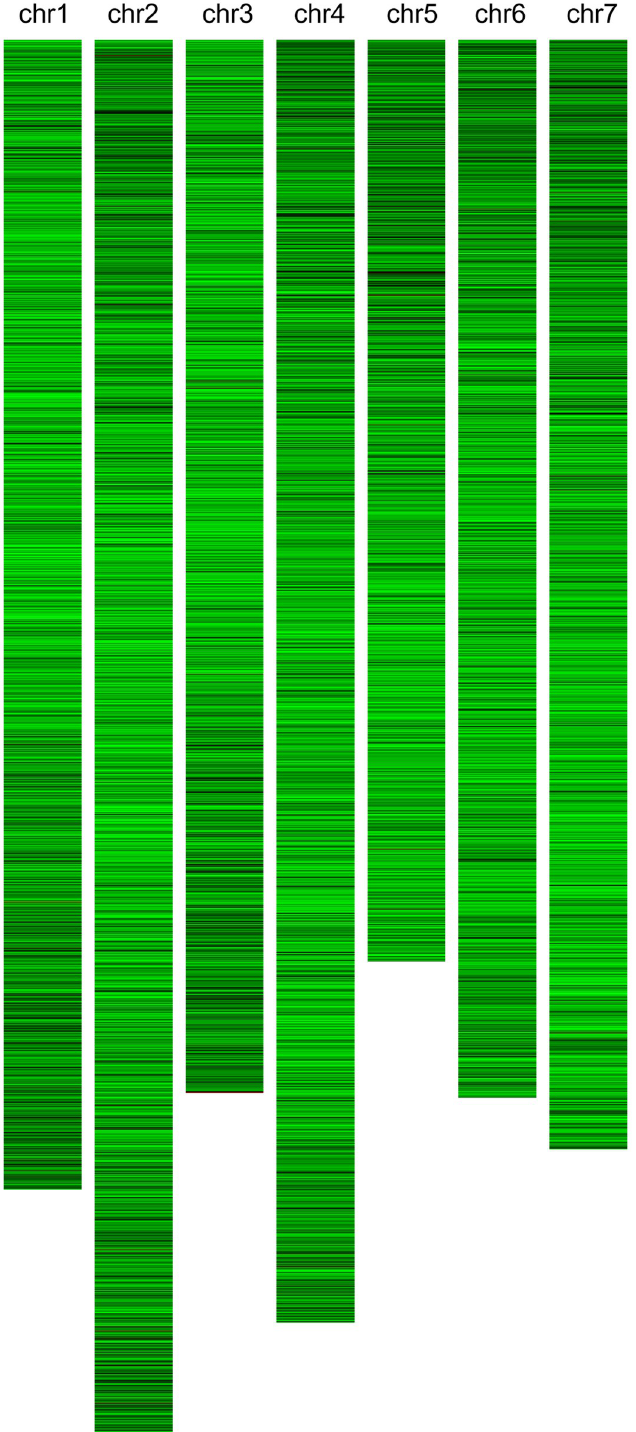
Fig 2. Visualisation of gene distribution and densities across the seven chromosomes of the R . idaeus ‘Anitra’ genome. The seven chromosomes are represented by the vertical strands, gene density is represented by the horizontal bands with a window of 10,000 bp. The darker the colour, the greater the density of genes.